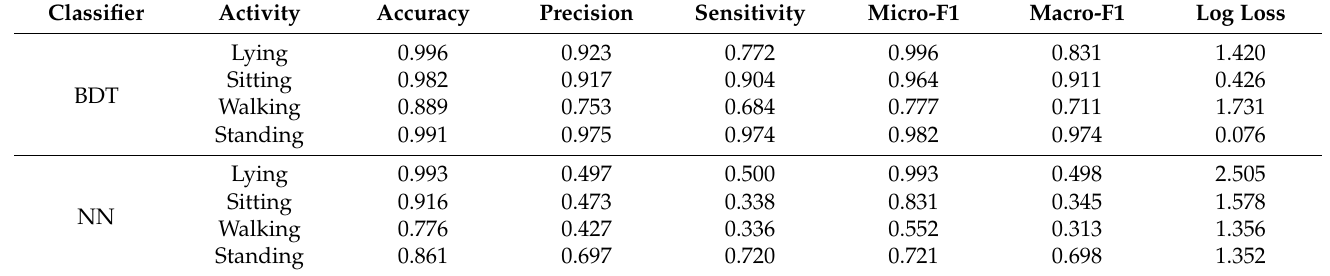
Table 7. Average results for phone context recognition (PCR) based on four physical activities using smartphone accelerometer.